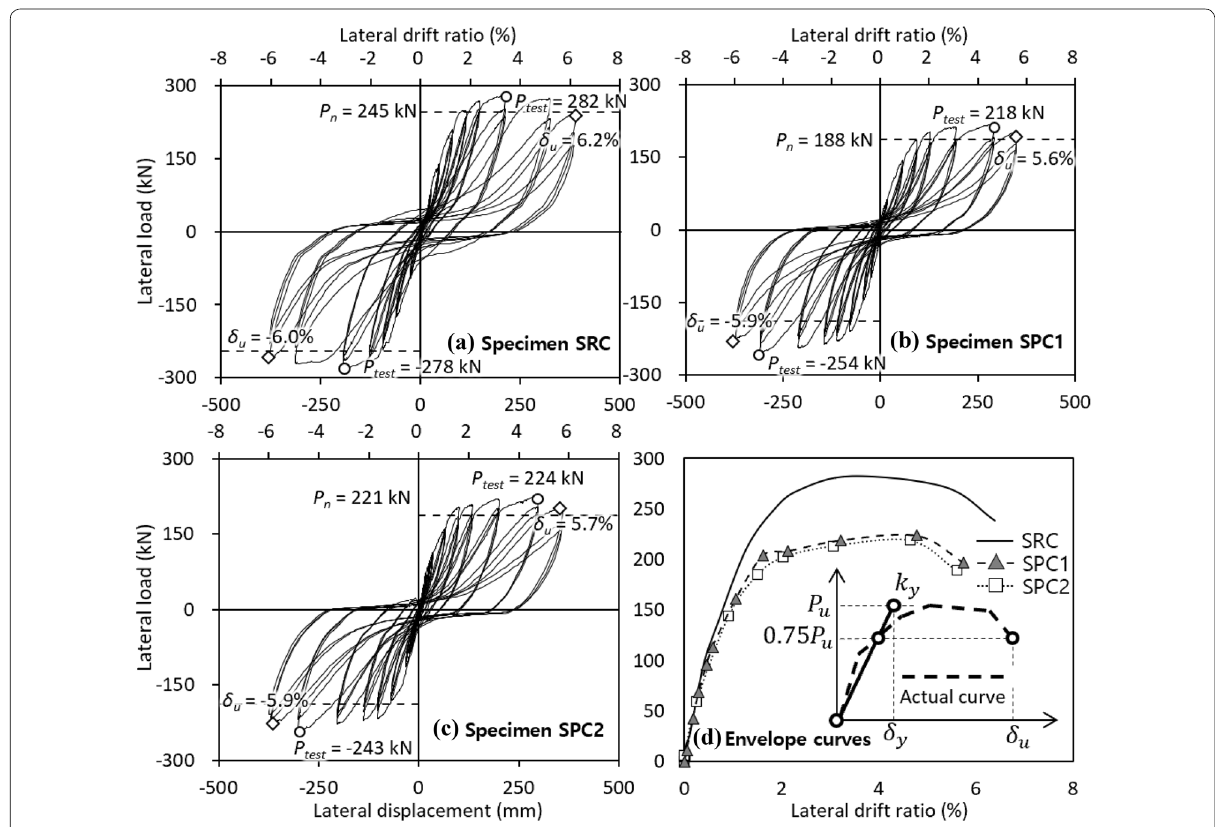
Fig. 15 Load – drift relations of specimens under cyclic lateral loading.